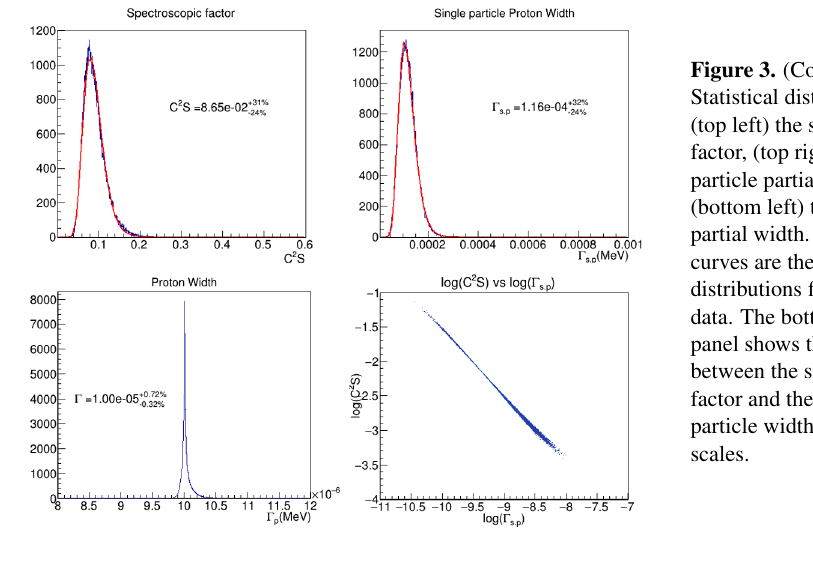
Figure 3. (Color online) Statistical distributions for: (top left) the spectroscopic factor, (top right) the single particle partial width, and (bottom left) the proton partial width. The red curves are the log-normal distributions fitted to the data. The bottom right panel shows the correlation between the spectroscopic factor and the single particle widths, in log